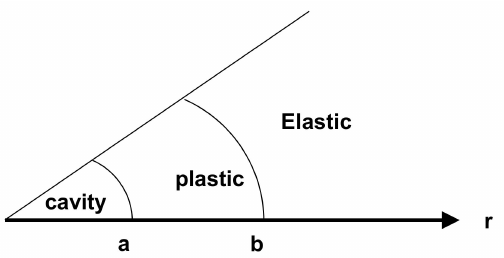
Figure 2. Distribution of the cavity pressure at the projectile